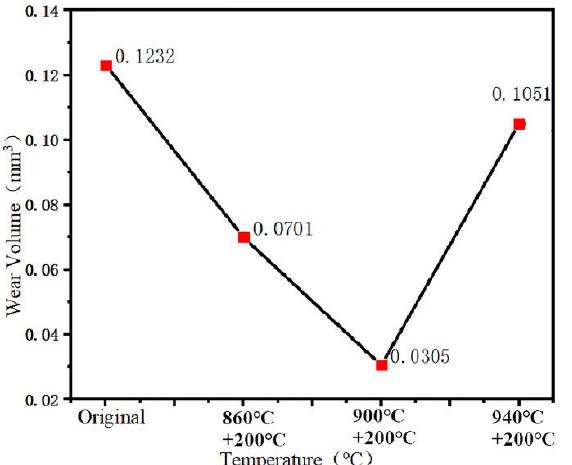
Figure 9. Wear volume of NM500/Q345 clad plate wear-resistant layer under different states of NM500.